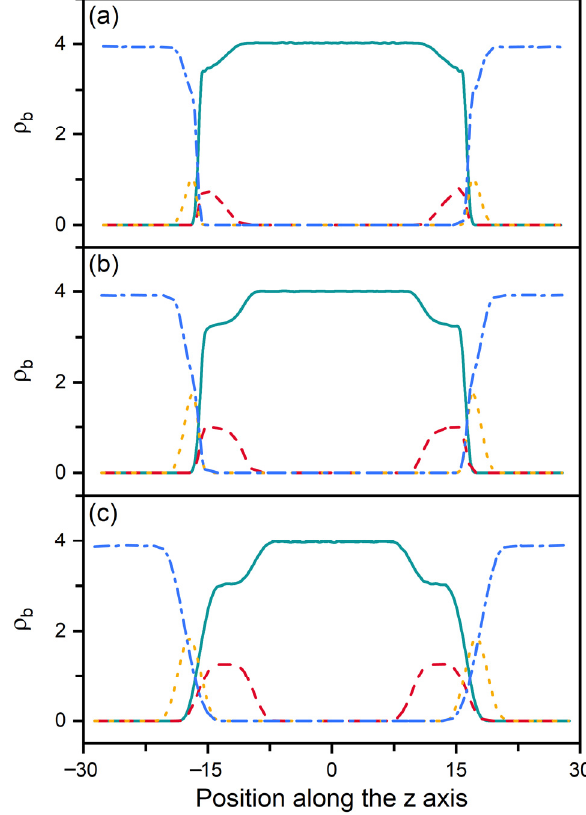
Figure 4. Bead density distributions of the mesogens (solid), amphiphile tails (dash), amphiphile heads (dot) and water (dash dot) in three representative anchoring configurations of nematic ( T = 0.6) LCs: ( a ) planar anchoring at ρ s = 0.2, ( b ) tilted anchoring at ρ s = 0.5 and ( c ) homeotropic anchoring at ρ s = 0.85.